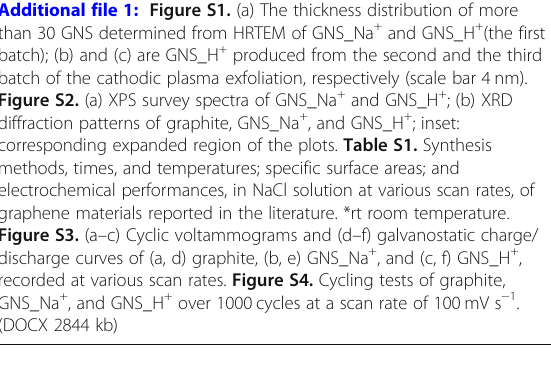
Additional file 1: Figure S1. (a) The thickness distribution of more than 30 GNS determined from HRTEM of GNS_Na + and GNS_H + (the first batch); (b) and (c) are GNS_H + produced from the second and the third batch of the cathodic plasma exfoliation, respectively (scale bar 4 nm). Figure S2. (a) XPS survey spectra of GNS_Na + and GNS_H + ; (b) XRD diffraction patterns of graphite, GNS_Na + , and GNS_H + ; inset: corresponding expanded region of the plots. Table S1. Synthesis methods, times, and temperatures; specific surface areas; and electrochemical performances, in NaCl solution at various scan rates, of graphene materials reported in the literature. *rt room temperature. Figure S3. (a – c) Cyclic voltammograms and (d – f) galvanostatic charge/ discharge curves of (a, d) graphite, (b, e) GNS_Na + , and (c, f) GNS_H + , recorded at various scan rates. Figure S4. Cycling tests of graphite, GNS_Na + , and GNS_H + over 1000 cycles at a scan rate of 100 mV s − 1 . (DOCX 2844